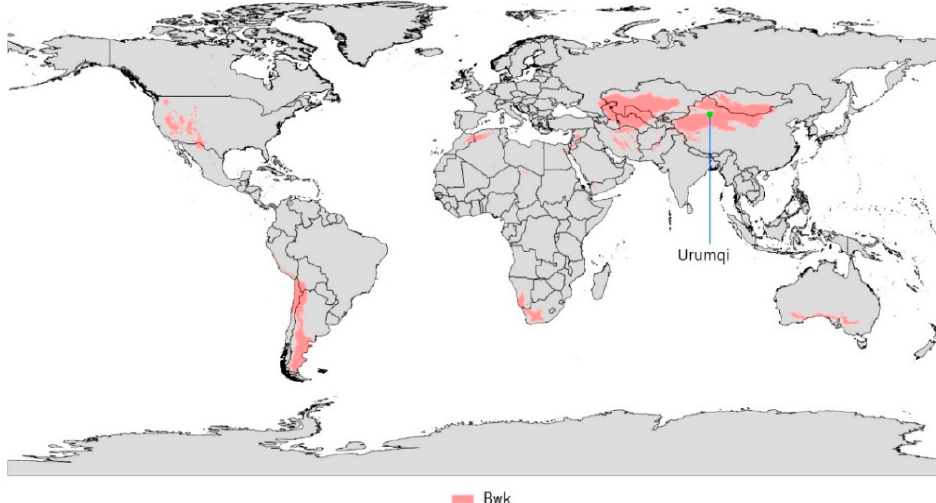
Figure 1. Climate classification and selection of sites.